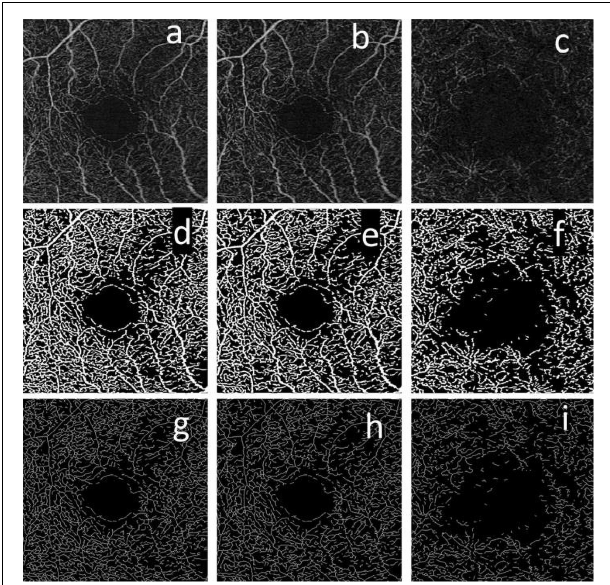
FIGURE 1 | Example of the en-face slabs used to compute the vessel closure (VC) metrics. The top row corresponds to the en-face slab generated for the full retina (FR) (a) , superficial capillary plexus (SCP) (b) , and DCP (c) . The second row corresponds to the binary version of the en-face slabs for the FR (d) , SCP (e) , and DCP (f) . The last row corresponds to the skeletonized version of the en-face slab for the FR (g) , SCP (h) , and DCP (i)